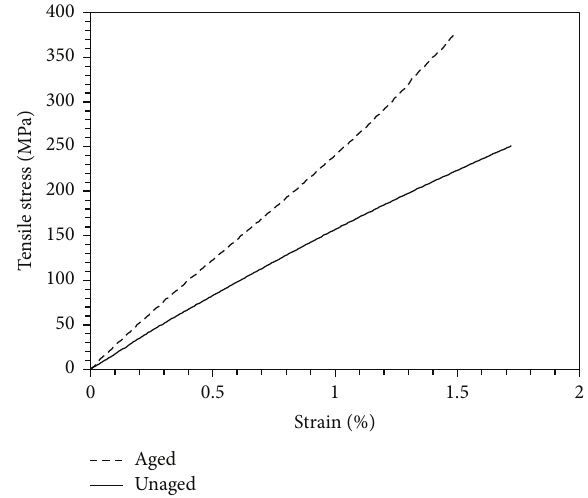
Figure 3: Stress-strain curves on EHG250-68-37 laminates before and after 800 h oxidative aging at 82 ∘ C.